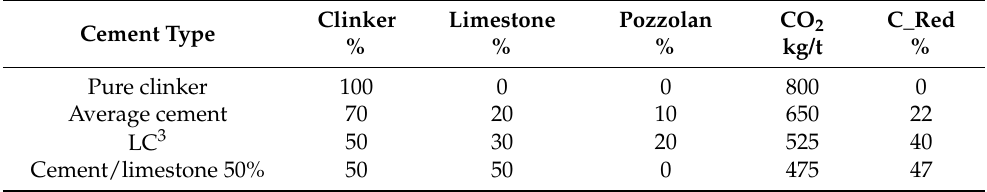
Table 3. Carbon footprint and reduction (C_red) of different kinds of cement made from clinker, limestone and calcined clay (metakaolin) [20,21]. The values of the carbon footprints from Table 2 are used for these calculations.